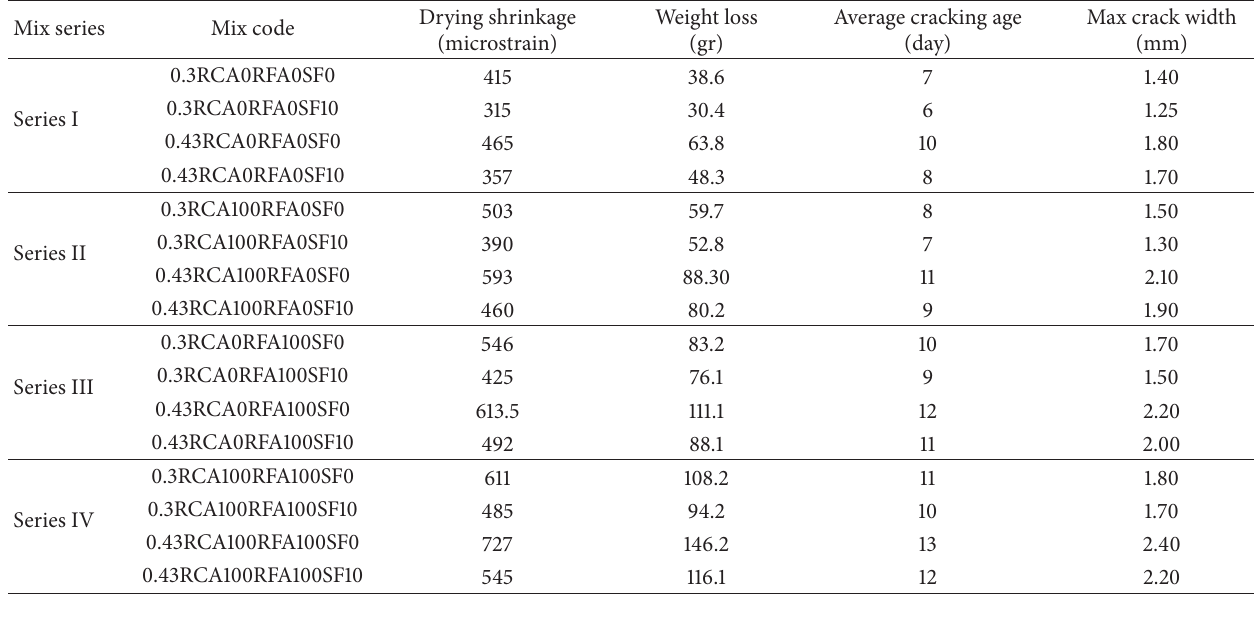
Table 6: Drying and restrained shrinkage performance of the SCCs at the end of the 56-day drying period.